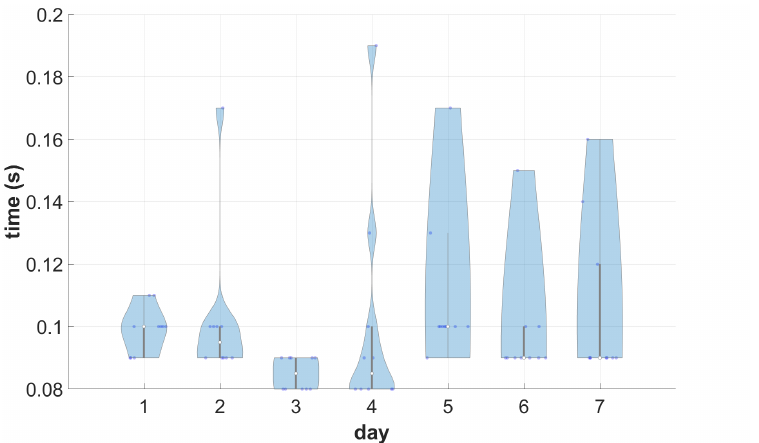
Figure 8. Searching all series created at a specific time. Total elapsed time was measured (since the issue of the request to display results).